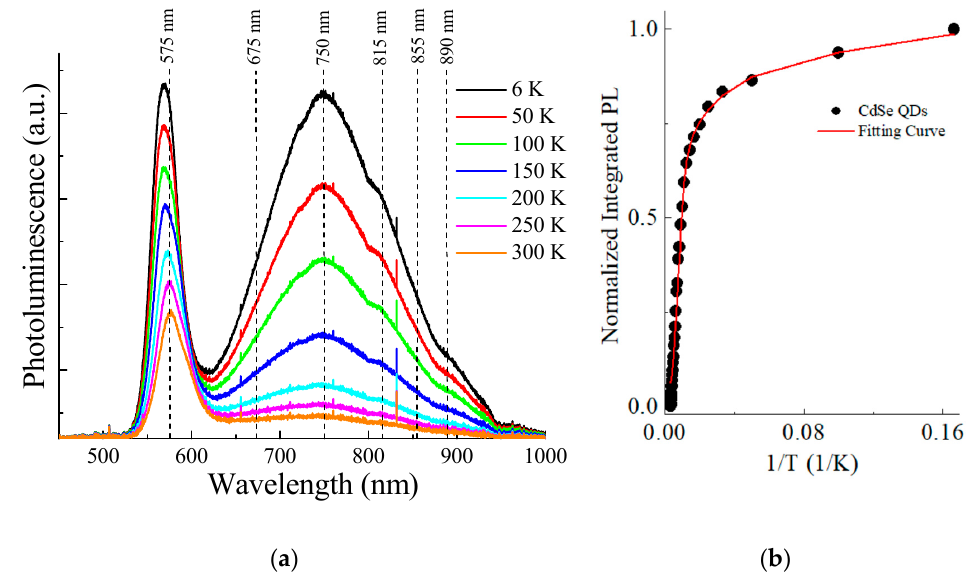
Figure 2. ( a ) Temperature-dependent photoluminescence of CdSe QDs at select temperatures. ( b ) In- tegrated PL intensity as a function of the inverse temperature. However, the band edge transition displayed a 2.6-fold decrease in emission intensity quenching with an 8.9-fold decrease in emission intensity from 6 K to 300 K. The surface- trapped state’s emission intensity decreases 3.4 times faster with increasing temperature than the band edge transition. This may be due to the large number of